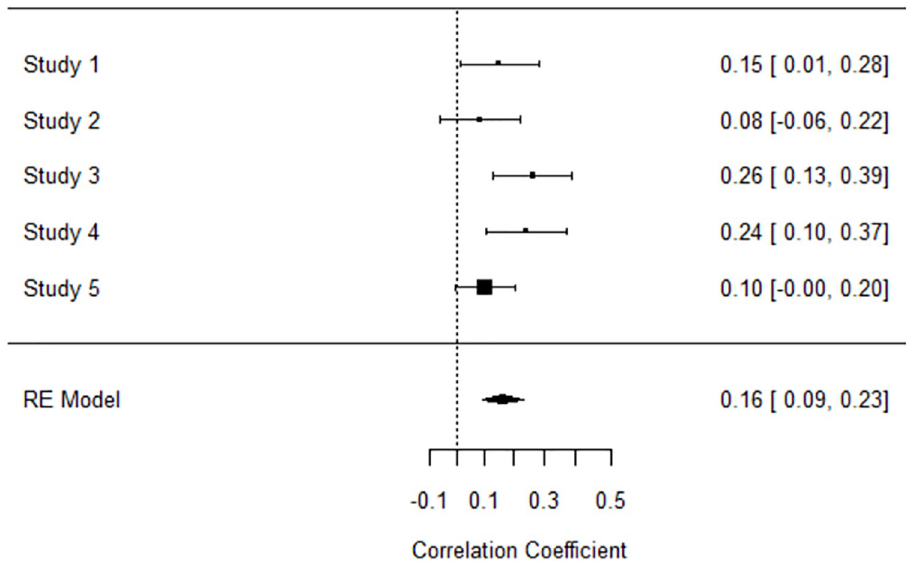
Fig 1. Forest plot of random-effects model for relationship between search for meaning and costly prosociality in Studies 1–5. N = 1129.